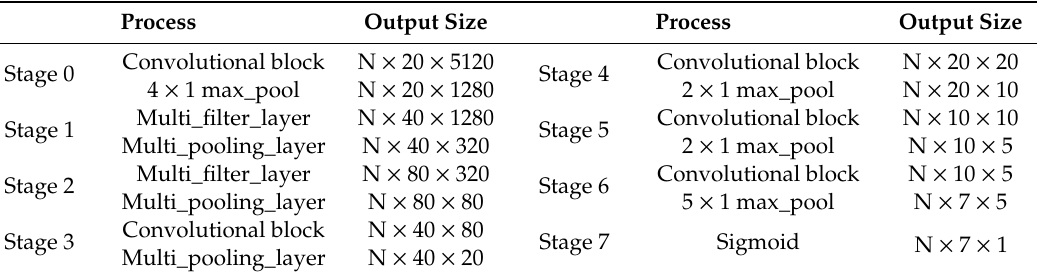
Figure 5. The structure of the ALSCN model. Table 1. Network process and output size of different stages.